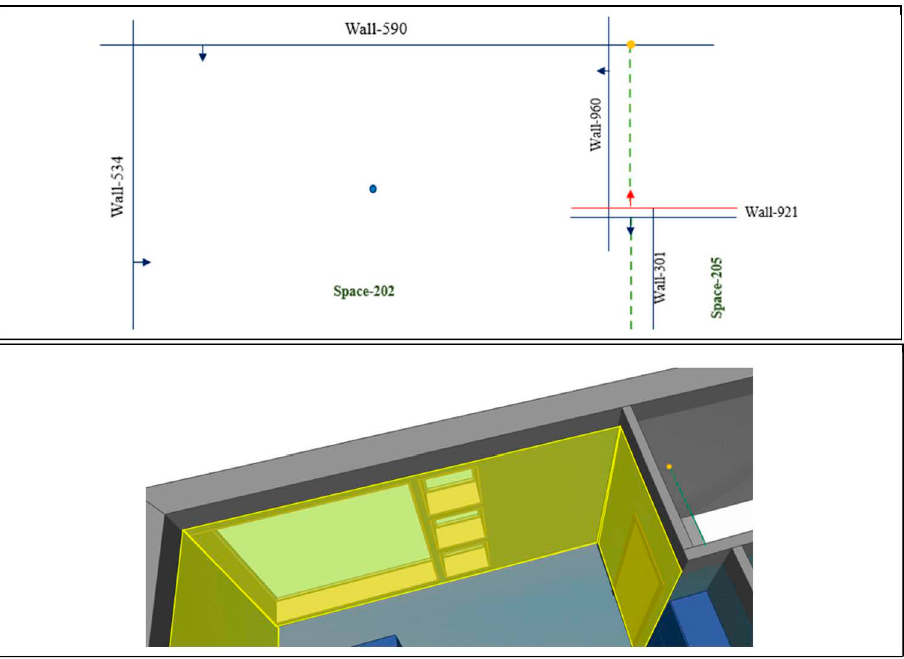
Figure 9. 2D and 3D perspectives of ray-crossing lines to find inner and outer faces. The arrows display the direction of the normal vector for each wallThe intersection of the red-face ray-crossing of wall-921 with the inner face of wall-590 generates a 3D point outside of all highlighted inner faces of space-202. Therefore the red face, considered the inner face in step one, is assigned as the outer face because it does not meet the condition. Moreover, the blue face of wall-921 is assigned to the inner face object for space-202. Finally, applying these three steps to all IFC model spaces, WWR, EWR, INW, FRR, and RRR are calculated accurately using the rich geometry computation in the proposed framework and storing these calculation results as the space objects’ attributes.